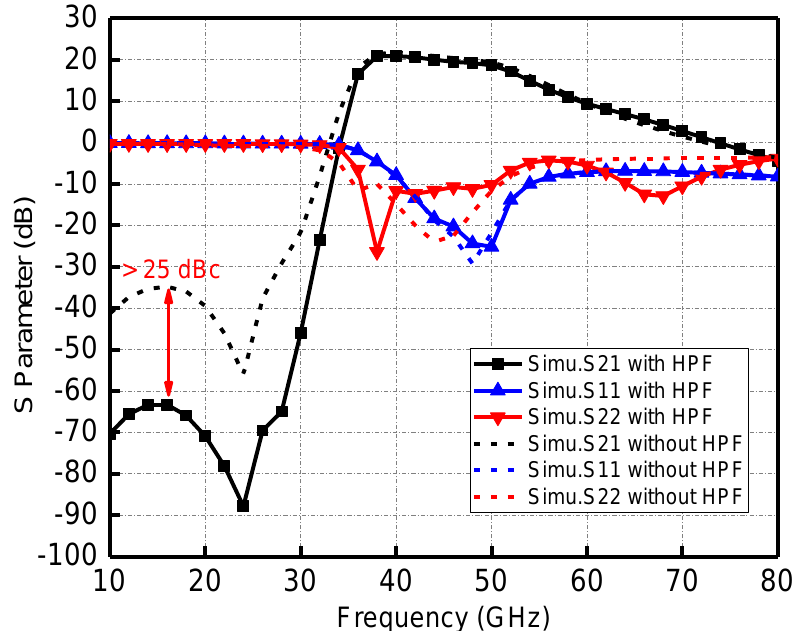
Figure 5. Simulated S-parameters of the LO driver power amplifier with or without HPF.